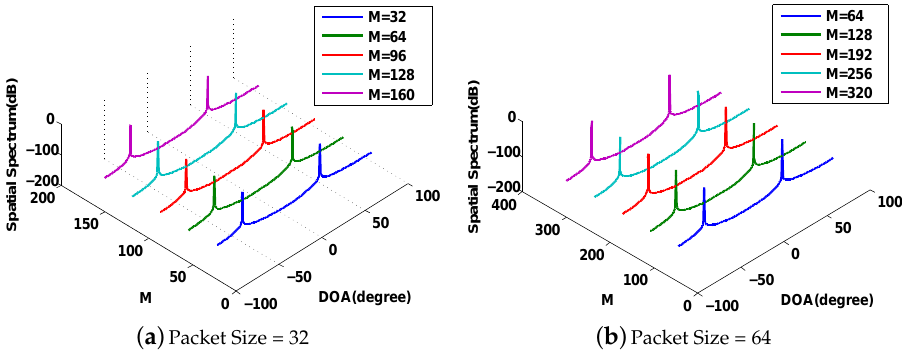
Figure 15. The DOA spatial spectrum for DCS-DDOA with the packet size being 32 and 64.